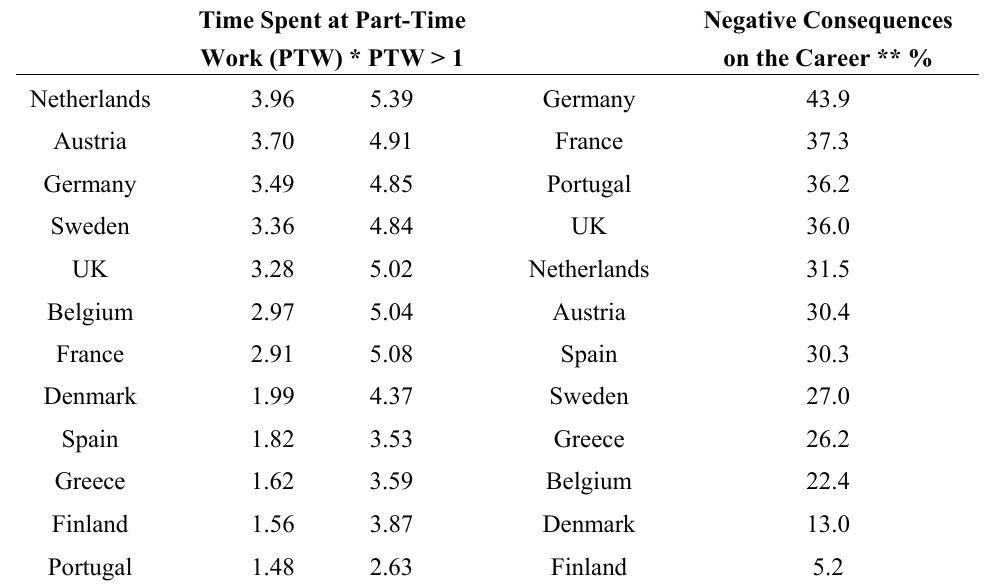
Table 7. Average time mothers spent at part-time work due to childcare and subjectively assessed career